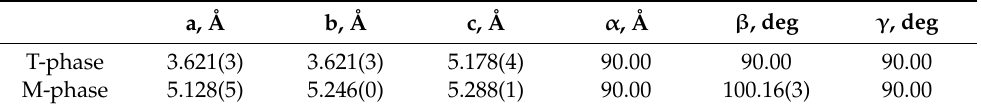
Table 1. Parameters of the unit cells of T- and M-phases in the ZrO 2 + 3 mol% Y 2 O 3 nanopowder according to neutron diffraction data.